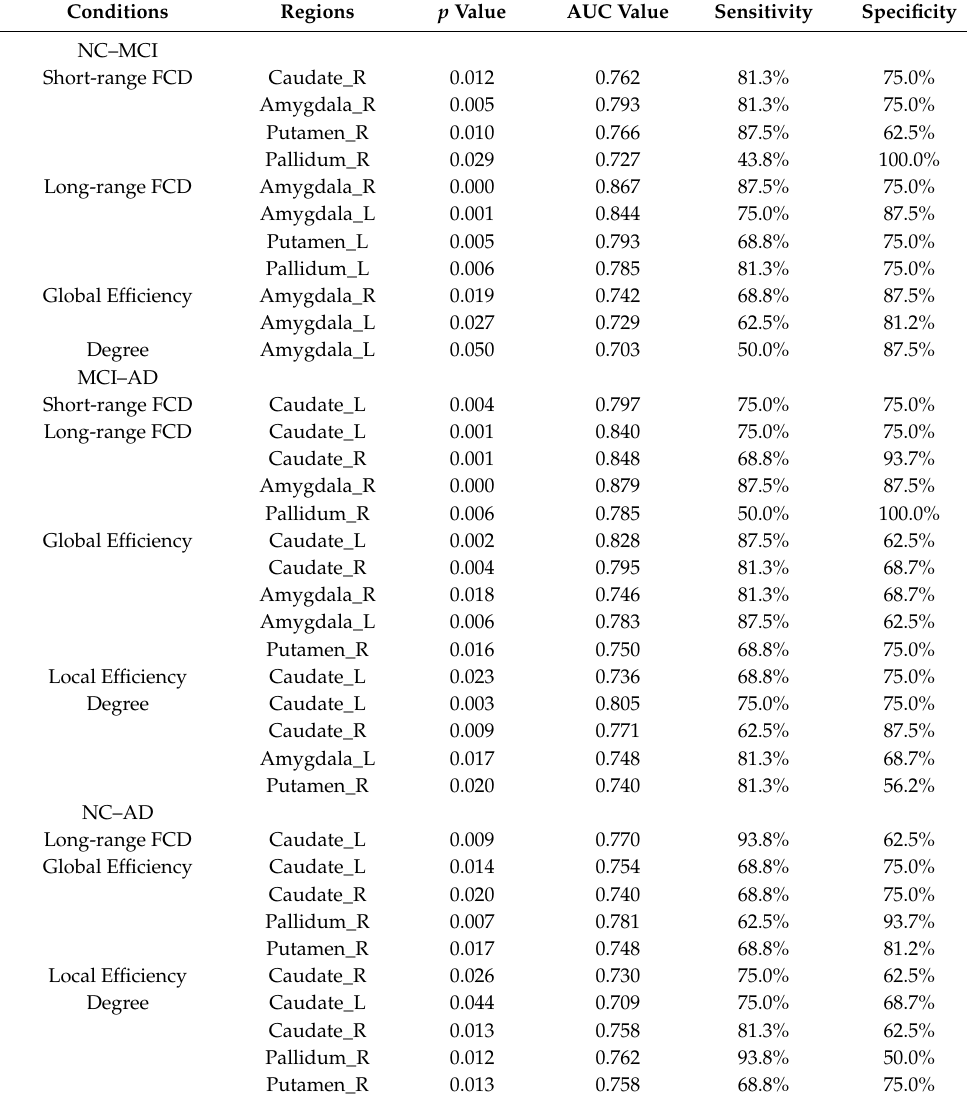
Table 3. Classification performances of FCD and graph theory values ( p <